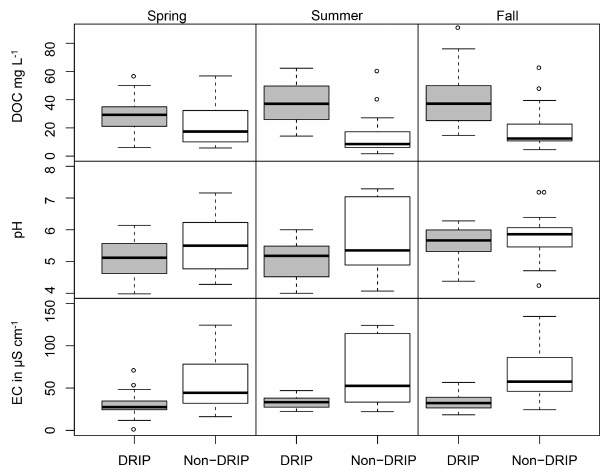
Figure 5. Groundwater chemistry in a seasonal gradient of the ri- parian wells. In each column DOC, pH, and EC are presented for the spring, summer, and fall season. Within each panel, DRIP box- plots are presented in gray, and non-DRIP boxplots are shown in